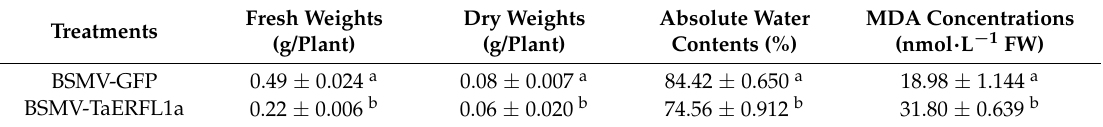
Table 1. Effect of TaERFL1a silencing on some growth and physiological parameters of wheat seedlings suffering from water